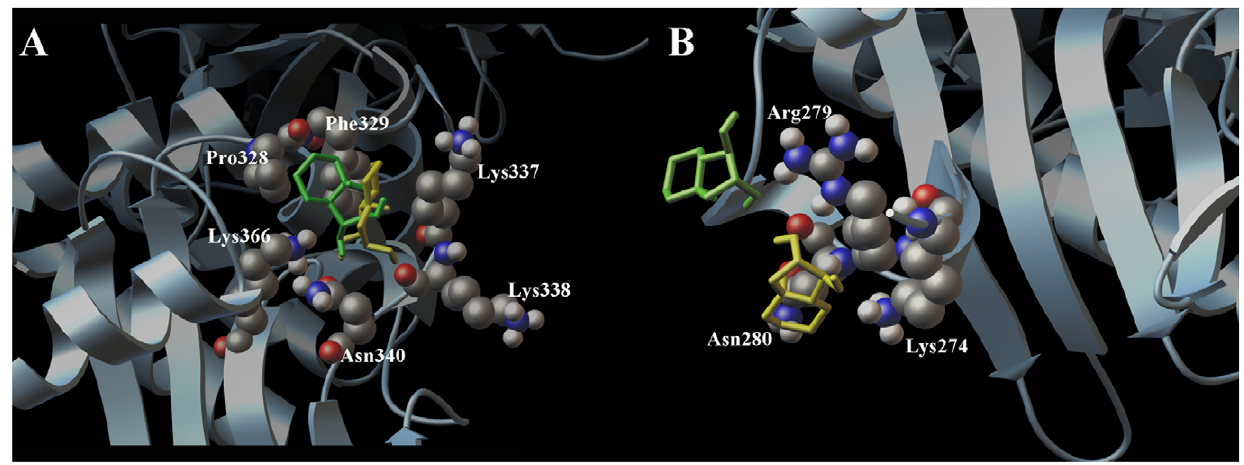
Figure 6. Docking calculation results. Three dimensional models (A and B) of ( + )-lentiginosine (1, yellow) and ( 2 )-lentiginosine (2, green) with HSP90. The target molecule is depicted by sky blue ribbon and the crucial amino acids by cpk (by atom type: C, purple; O, red; N, dark blue, H, white).